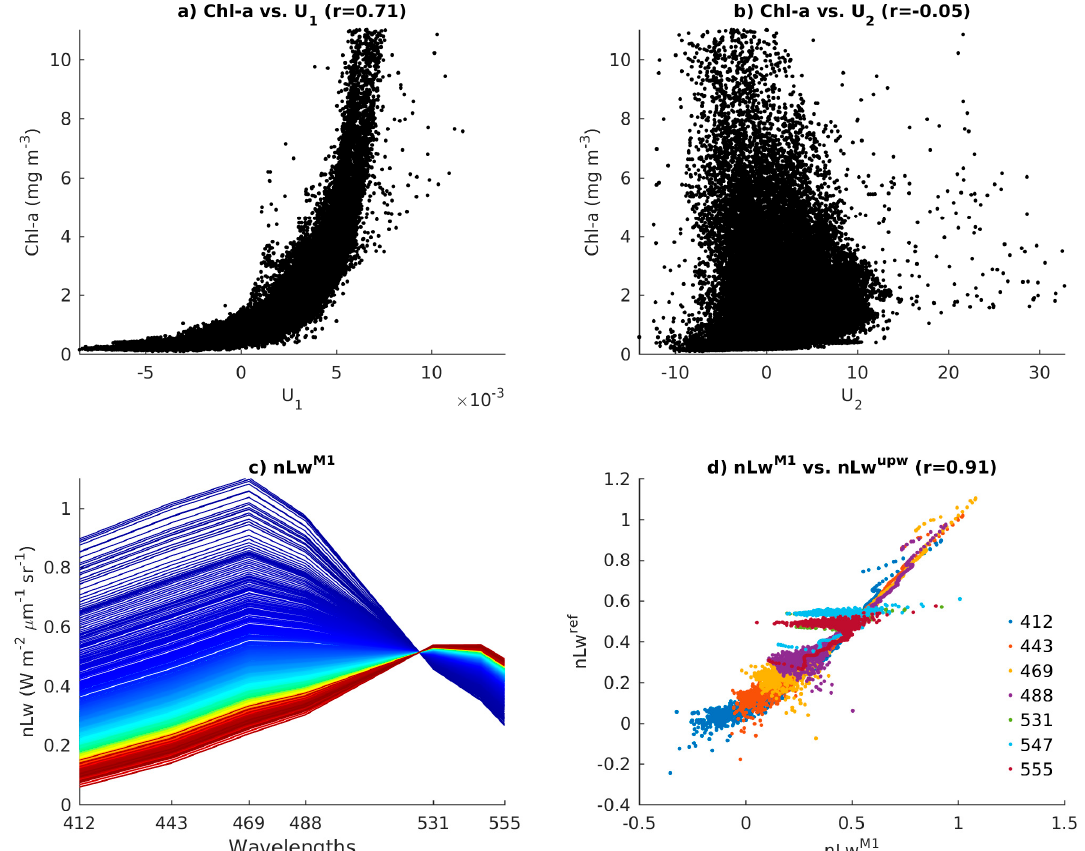
Figure 14. The relationship between MODIS-A Chl-a and the spatial pattern of the: first ( a ); and second ( b ) modes resulting from of the SVD of a R matrix composed by MODIS-A nLw data off central Chile (35–38°S, 72–76°W) on the dates of the PHYTOFRONT cruise (4–6 February 2014). ( c ) The regional reference model (nLw M1 ) derived from the reconstruction of the first SVD orthogonal mode M 1 . ( d ) The relationship between nLw M1 and nLw upw for each wavelength.